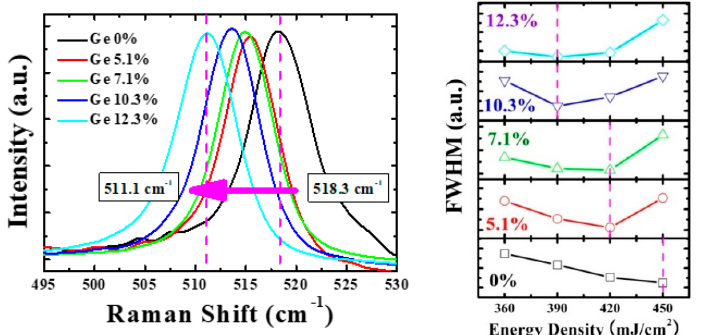
Figure 4. ( left ) Raman spectra of poly-Si 1 − x Ge x thin films ( right ); full width at half maximum (FWHM) characteristics extracted from the Raman spectra of poly-Si 1 − x Ge x films formed with different laser energy densities and Ge contents.